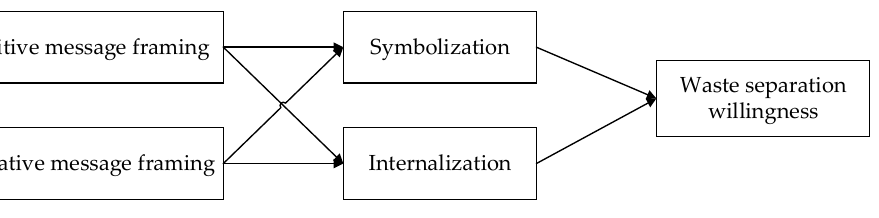
Figure 1. Research framework.